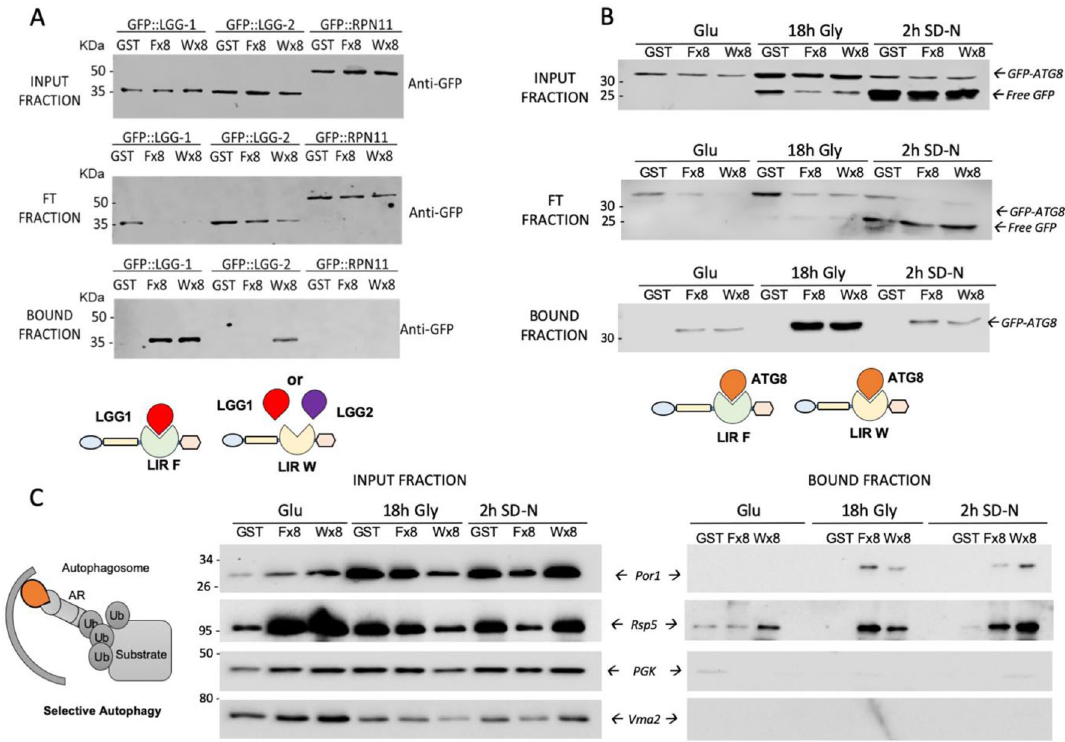
Figure 4. LC3 traps capture ATG8 orthologs in several biological models. ( A ) In vivo capture of LGG-1 and LGG-2 from C. elegans using LC3 traps. LGG-1 (GABARAP homolog) and LGG-2(LC3 homolog) were purified using tetrameric F and W LC3 traps from 3 different C. elegans strains as indicated (500 µg of total proteins from lysates were used per sample). GST-pulldown was performed as previously indicated and collected fractions were analyzed by Western blot using an anti-GFP. ( B ) Clones expressing GFP-Atg8 were cultured in glucose containing medium (glu), glycerol containing medium for 18 h (18 h Gly) or during 2 h in nitrogen depleted medium (2 h SD-N). One milligram/point of total protein yeast extracts from were incubated with Fx8, Wx8 LC3 traps or GST control. GST pulldown was performed as previously indicated and collected fractions were analysed by Western blot using an anti-GFP. ( C ) LC3-trapped fractions were analysed for the presence of the mitochondrial membrane protein Por1, suggestive of mitochondrial sequestering in autophagic compartments. The presence of other proteins (Rsp5, PGK, Vma2) in the different fractions was tested by Western blot analysis. PVDF membranes were cut before antibody incubation to be able to detect several proteins from the same